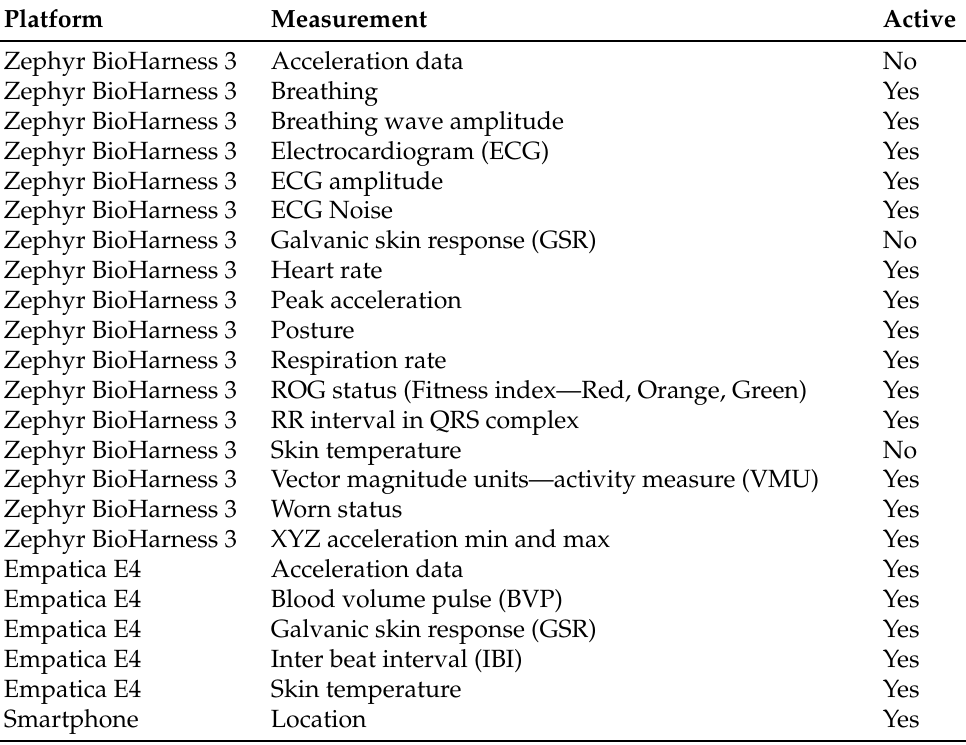
Table 1. Complete list of platforms and measurements available used in this